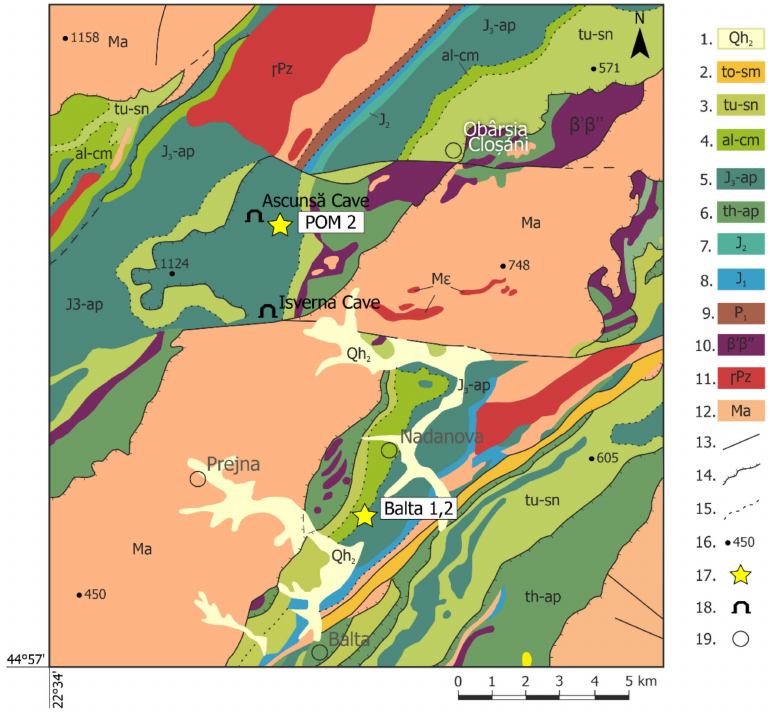
Figure 2. Geological map of the region (modified after Codarcea et al. [28]): 1. Quaternary: gravel and sand; 2. Tortonian–Sarmatian; 3. Turonian–Senonian m é lange unit; 4. Albian–Cenomanian: marly limestones, sandstones and clays (Nadanova formation); 5. Upper Jurassic–Aptian: limestones, marly limestones (Sinaia beds); 6. Tithonian–Aptian: marly limestones, sandstones, conglomerates, dolerites; 7. Middle Jurassic: limestones, marly limestones, arkosic sandstones; 8. Lower Jurassic: conglomerates, sandstones, shales, coals; 9. Permian: conglomerates, sandstones, red shales; 10. Meso- zoic and Permian migmatites: β ’dolerite, β ”-spilites; 11. Paleozoic magmatites and Precambrian granites; 12. Neoproterozoic: micaschists and gneisses; 13. Fault; 14. Thrust fault; 15. Lithologic limit; 16. Altimetry; 17. Soil profile; 18. Cave entrance; 19.